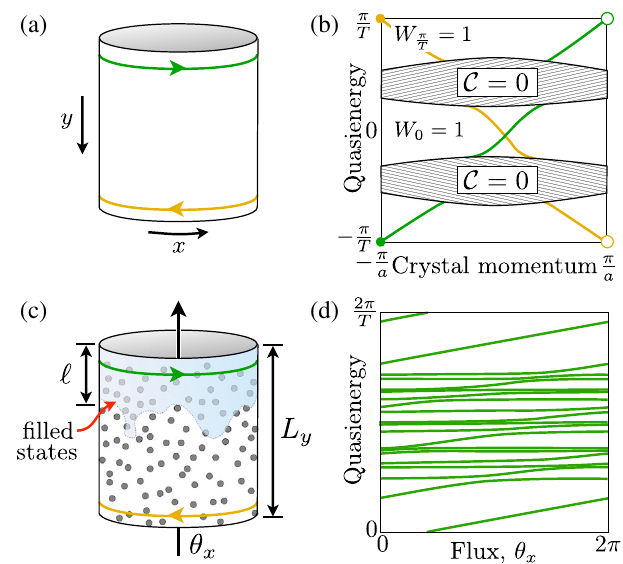
FIG. 3. Edge states and spectral flow in the AFAI. (a) The parent phase of the AFAI is a clean system without disorder, where all Floquet bands have Chern number zero but the winding number (2) is nonzero in all gaps. In a cylinder geometry, chiral edge states propagate along the upper and lower boundaries, only at quasienergies within the bulk gaps. (b) The corresponding spectrum, shown as a function of the conserved circumferential crystal momentum component. (c) When disorder is added, all bulk states become localized while the chiral edge modes on the cylinder persist. When all states are filled near one end of the cylinder, a quantized current flows along the edge. (d) With disorder, crystal momentum is no longer a good quantum number. However, the spectrum of states localized near the upper edge, displayed as a function of the flux θ x threaded through the cylinder, clearly displays a nontrivial spectral flow. The spectral flow fully winds around the quasienergy zone, accounting for the quantized pumping in the AFAI